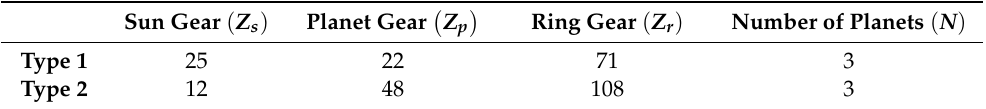
Table 1. Parameters of planetary gearbox.